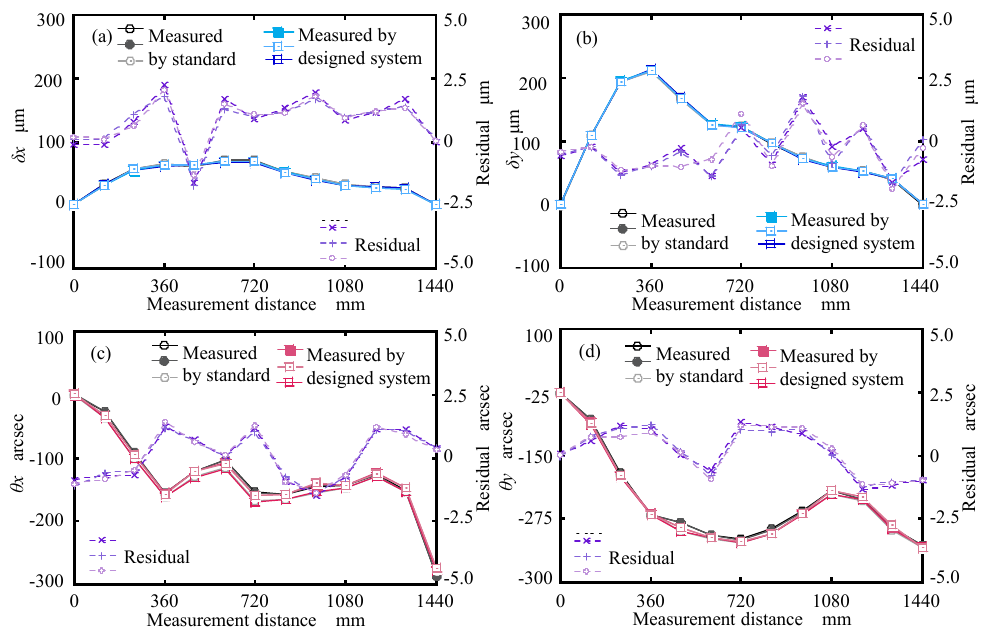
Figure 14. Measured results of ( a ) δ x , ( b ) δ y , ( c ) θ x and ( d ) θ y measured three times.